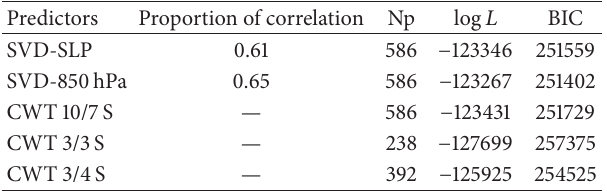
Table 4: Fitting by NHMM with seven states of precipitation at the 19 stations, taking into account as predictors the first summary variable of the SVD decomposition of SLP and geopotential at 850 hPa and NHMM with different states, with 10 and 3 predictors of